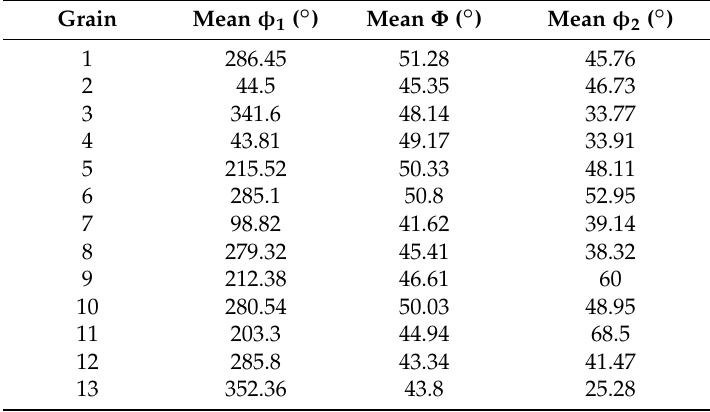
Figure 5. Bright field TEM micrograph and the corresponding selected area diffraction pattern after one ECAP pass showing a high fraction of deformation twins. Selected twins/twin ‐ matrix lamellae are indicated by arrows. Table 4 contains the results of the twin ‐ orientation analysis, i.e., the disorientation angle of each Table 3. The mean orientations of the grains marked in Figure 4. pair of neighboring grains together with their nearest disorientation axis, the offset from the nearest rotation axis, and the deviation angle from the ideal 60°<111> twinning orientation relationship. The deviations were typically around 10°, but there were also several larger disorientations, up to 50°. This analysis provided evidence that the twins drifted away from their initial ideal orientation